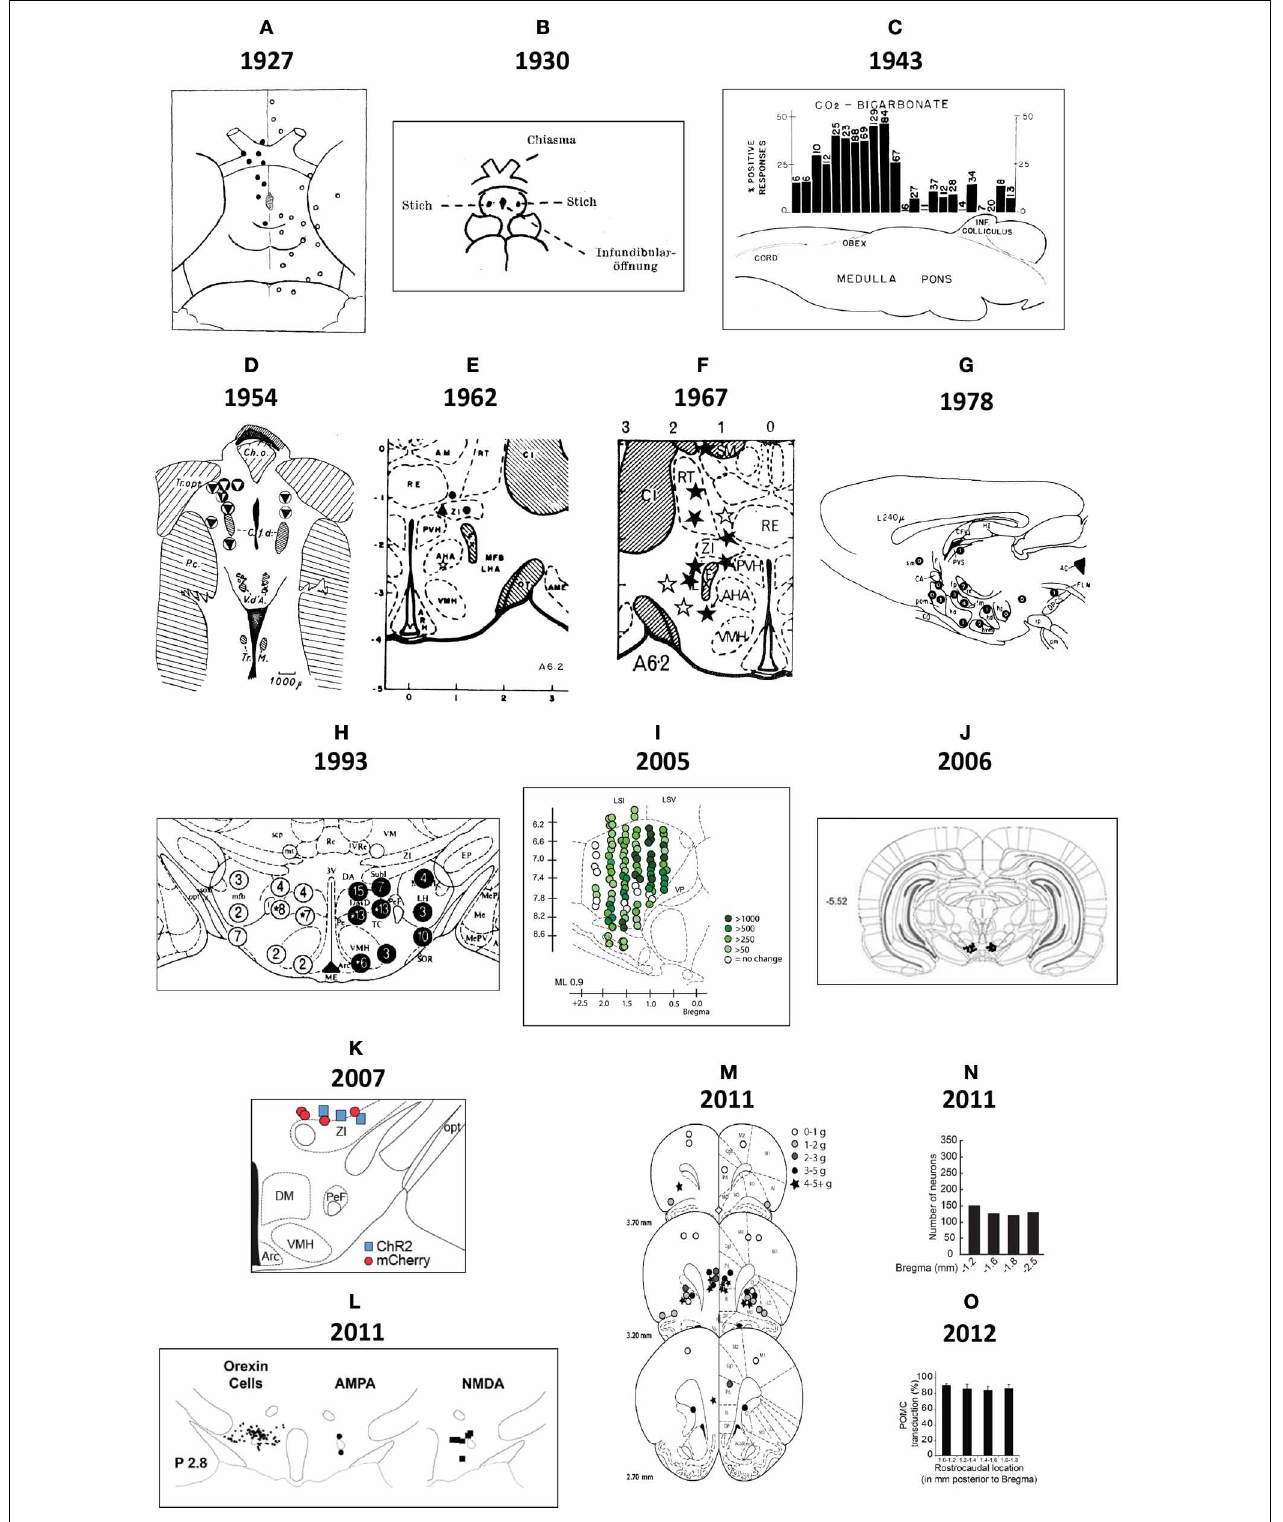
FIGURE 2 | (A) This drawing is Figure 9 of Demole (1927), which provides what is likely the first published map of central chemical injection sites for the hypothalamus. CaCl 2 injections were made into the anterior hypothalamus of cats to produce sleep. The ventral surface of the brain is shown, with